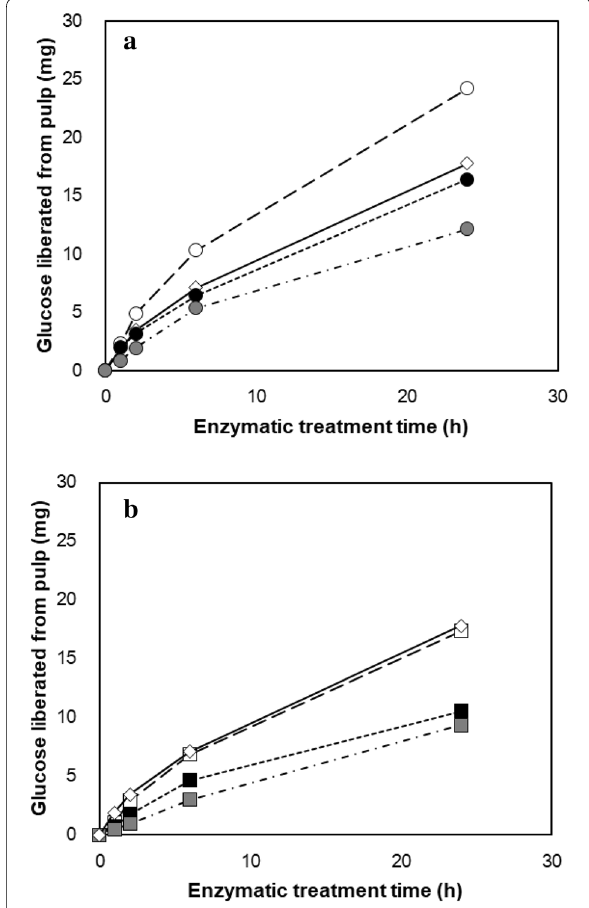
Fig. 7 Enzymatic saccharification of delignified pulp with the enzyme dose at 3.2 FPU/g: a larch SP and b acacia SP. Open diamond: filter paper, black circle and gray circle: larch SP with a kappa number 64.3 and 127, respectively, black square and gray square: acacia SP with a kappa number 23.0 and 57.9, respectively, open circle and open square: delignified SP prepared from larch SP with the kappa number 64.3 and acacia SP with the kappa number 23.0, respectively.